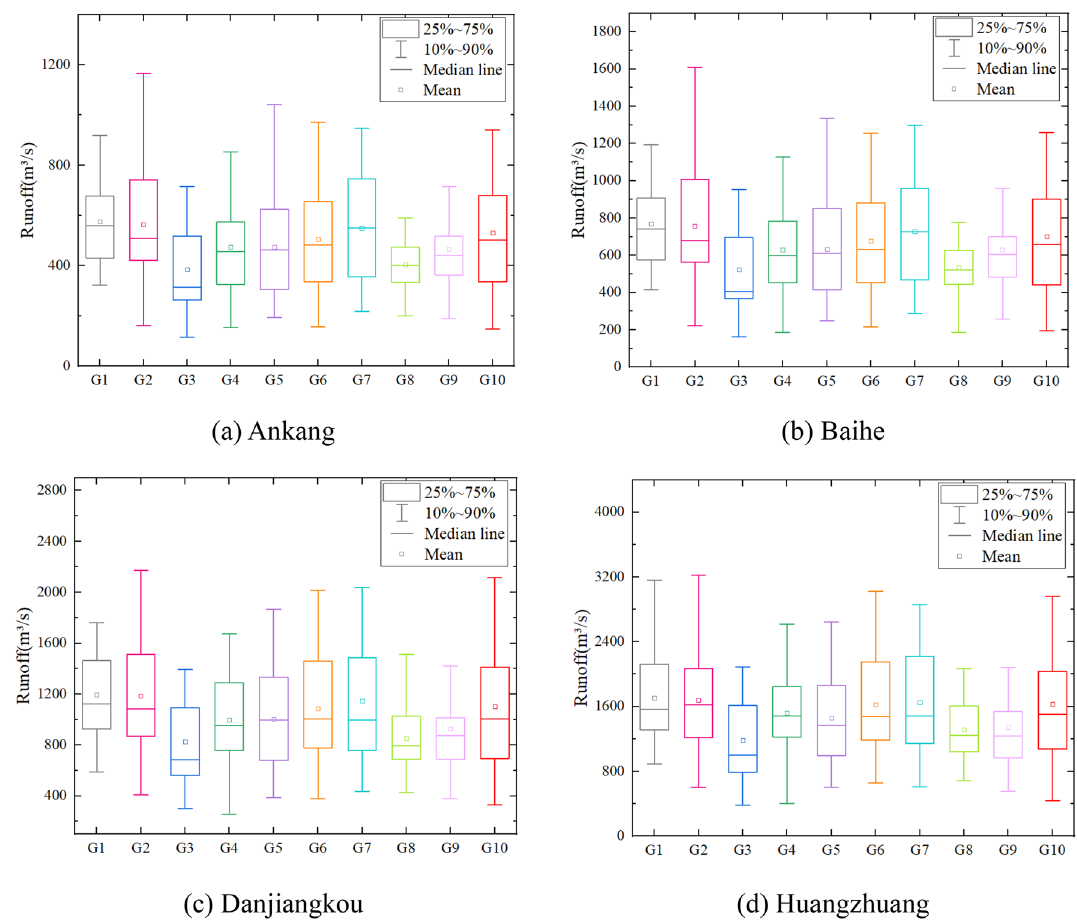
Figure 4. Comparison of future runoff series at various hydrological stations simulated by ten GCMs.